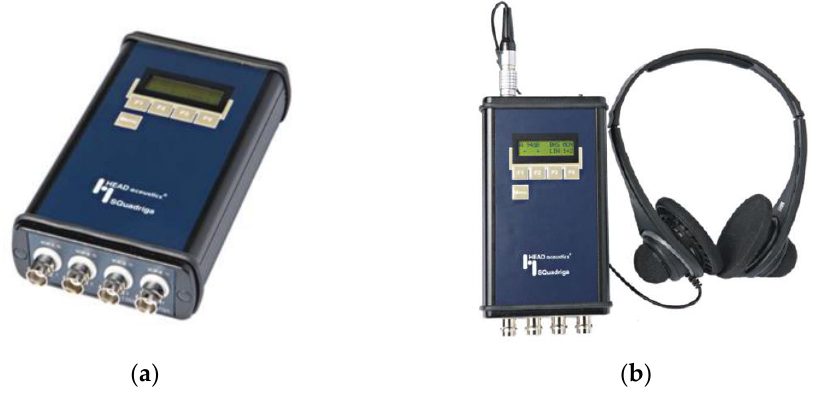
Figure 2. ( a ) SQuadriga Headphone Booster; ( b ) SQuadriga Headset BHS.